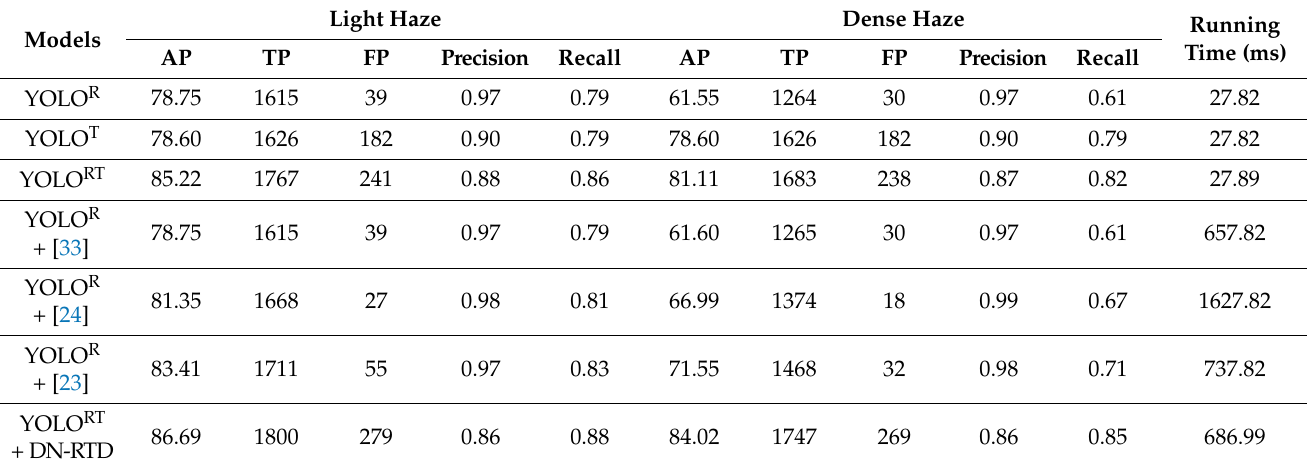
Table 4. Vehicle detection performance comparison by model according to the haze level.